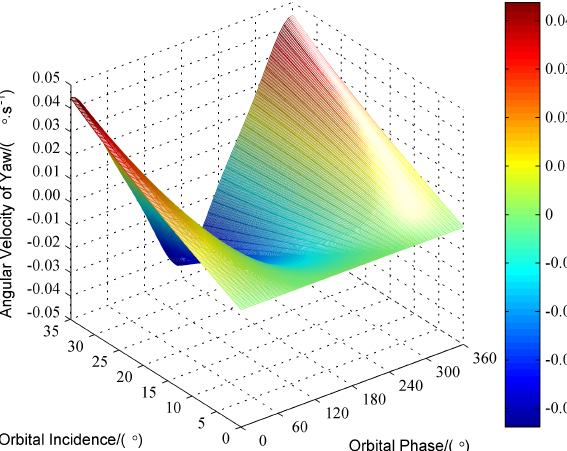
Figure 9. Simulations of yaw angular